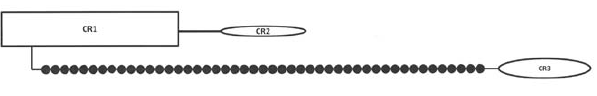
Figure 3. Statistical parsimony networks for combined COI and 16S rDNA haplotypes of Bactrocera caudata . Lines represent parsimonous connections between haplotypes and the small circles indicate missing haplotype. The size of square or oval corresponds to the haplotype frequency.